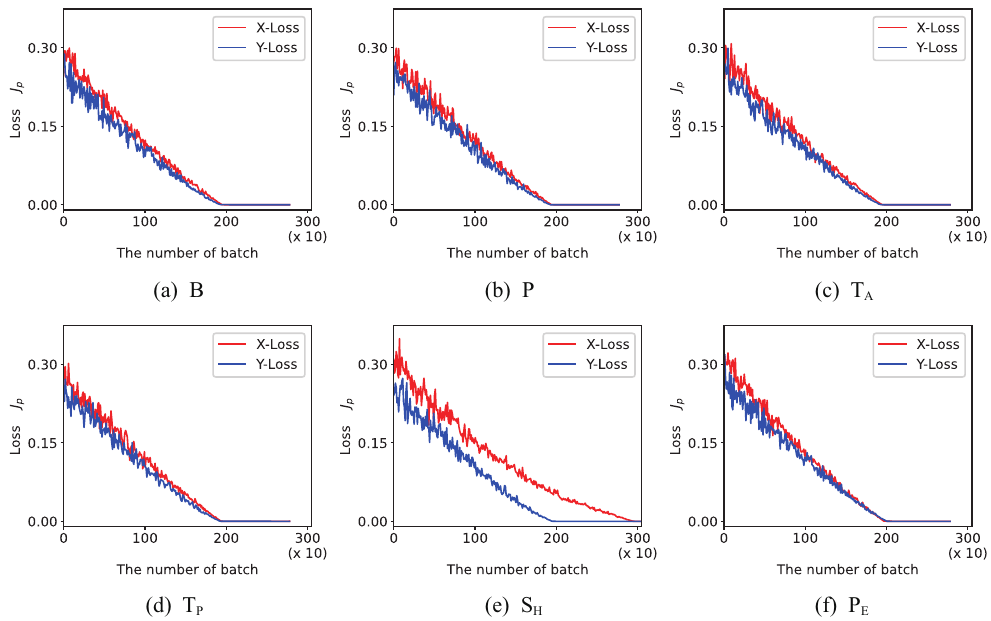
Figure 8. The Loss J p for different types of geometric distortions of star images generated along the earth orbit: ( a ) B (barrel), ( b ) P (pincushion), ( c ) T A (tangential), ( d ) T p (thin prism), ( e ) S H (shear) and ( f ) P E (perspective). The abscissa axis is the batch size, which is 128. The initial weights of different distortions were the